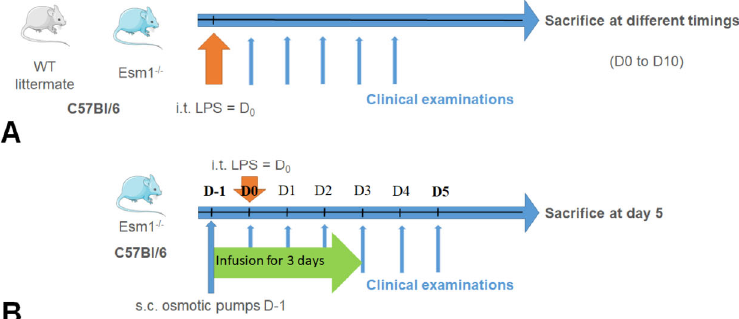
Figure 1. Experimental protocols. The first protocol ( A ) was performed to study differences of the LPS induced ALI between WT littermate and Esm1 − / − C57Bl/6 mice. The intra tracheal instillation of LPS was performed at D0, the clinical examination, with noninvasive measurement of oximetry, was performed each day, and the mice were sacrificed at different times to describe the features of ALI at each timing. The second protocol ( B ) was performed to study the effect of the continuous infusion of mouse endocan by osmotic pumps in Esm1 − / − mice. Osmotic pumps were filled with either endocan or PBS and implanted subcutaneously one day before i.t. LPS instillation. Clinical